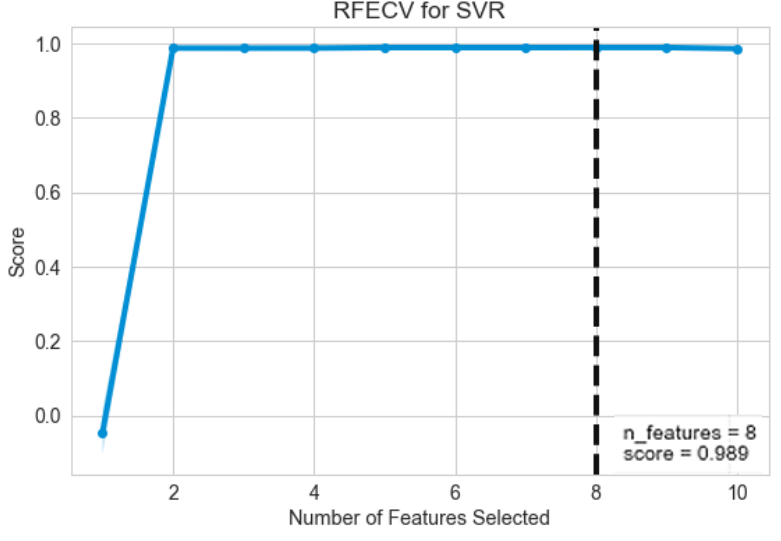
Figure 12. Result of Cross-validation (RFE).